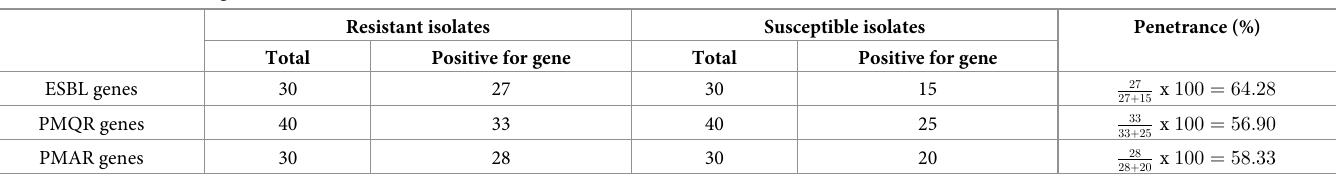
Resistant isolates